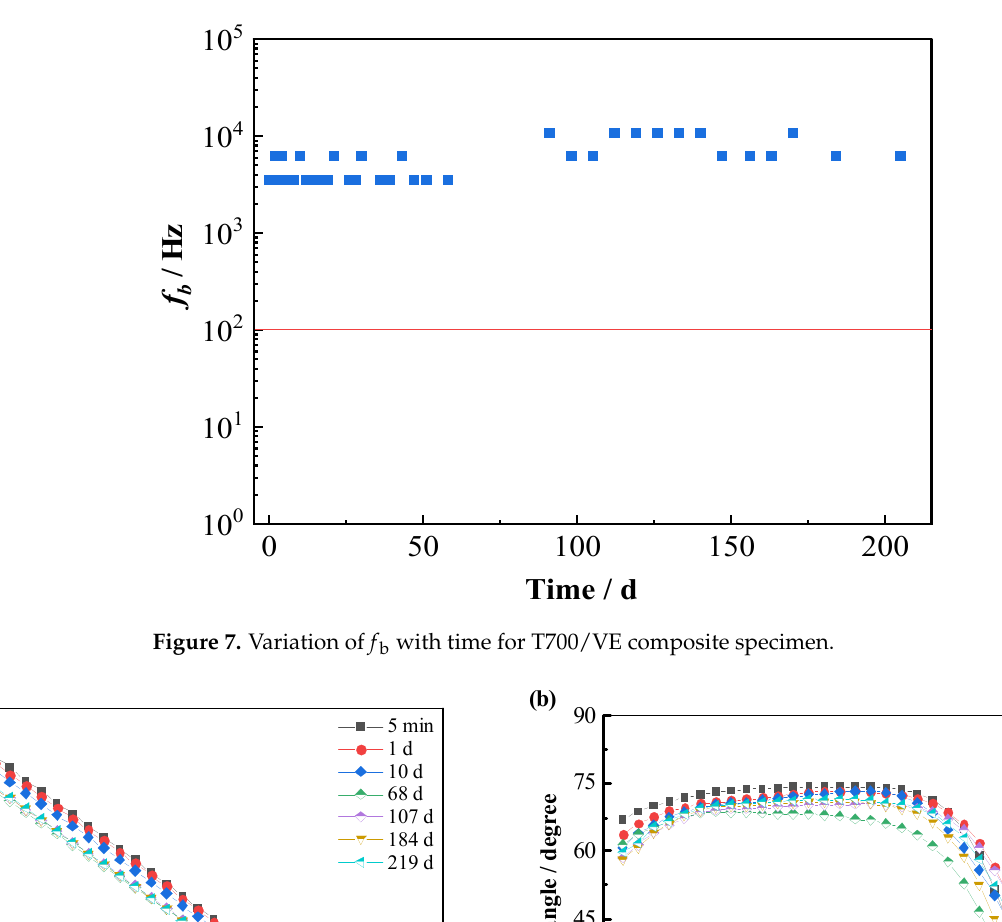
Figure 7. Variation of f b with time for T700/VE composite specimen.